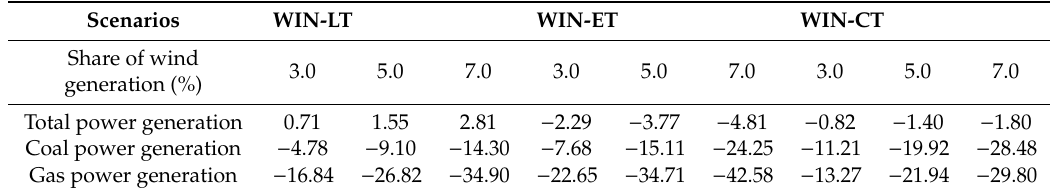
Table 11. Changes in total power generation and fossil fuel generation due to the increased wind generation (% changes from the base